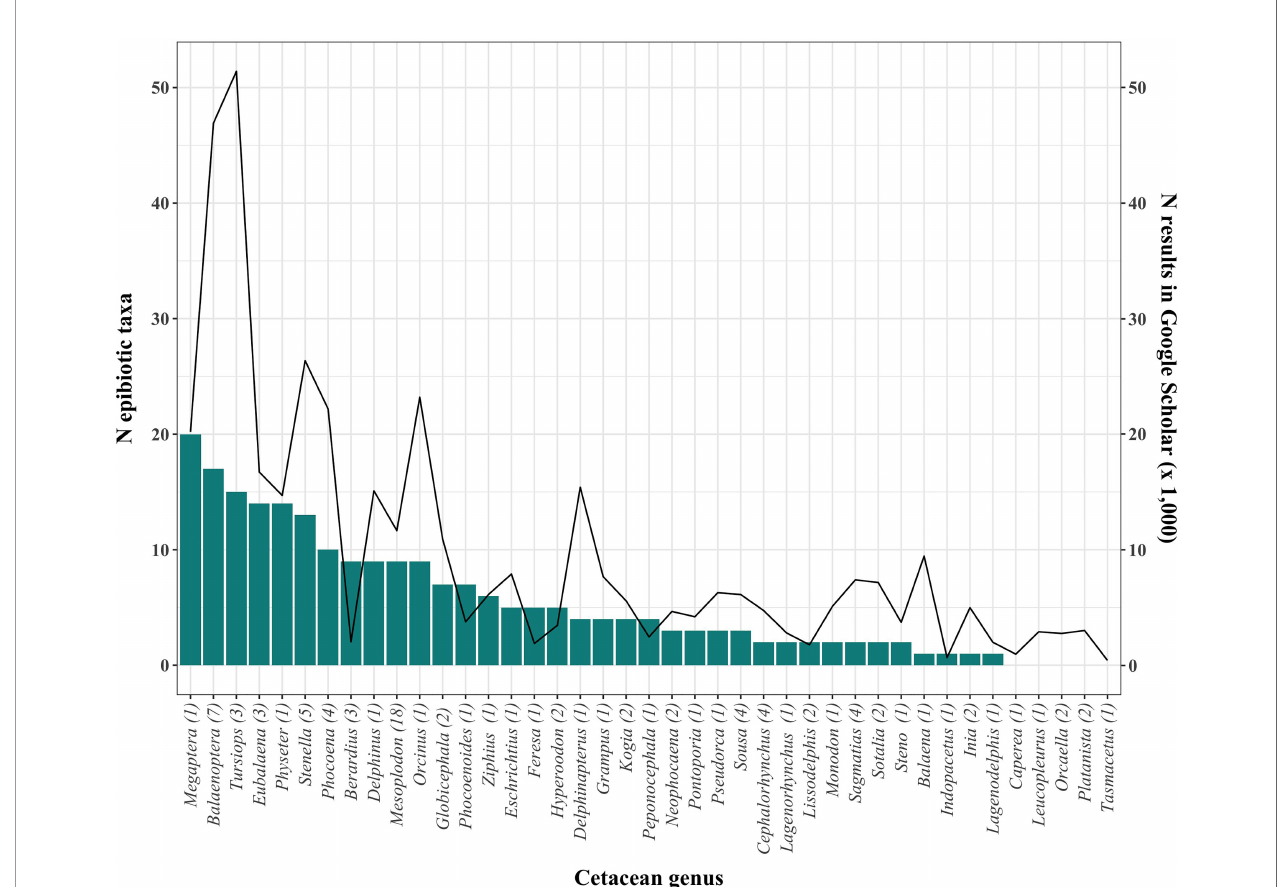
FIGURE 3 | Number of epibiotic species (bars, left y-axis) and total number of general results in Google Scholar (line, right y-axis) of each cetacean genus. The number of cetacean species in each genus is shown in